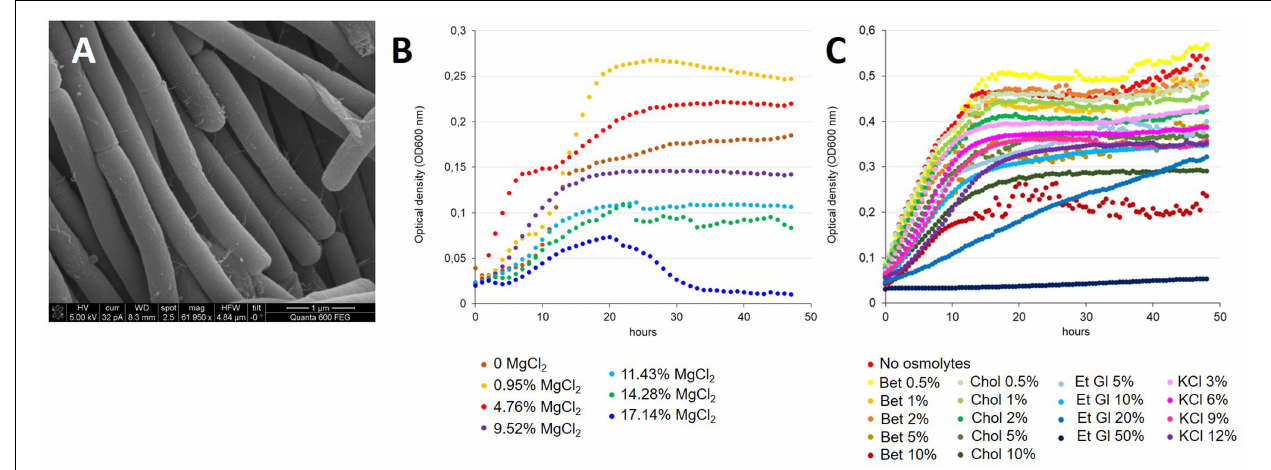
FIGURE 1 | Morphology (A) and growth (B,C) of V. dokdonensis strain 21D. In (A) , SEM image of strain 21D. In (B) , strain 21D growth in presence of increasing concentrations of MgCl 2 . In (C) , strain 21D growth in presence of increasing concentrations of different osmolytes. Bet, betaine; Chol, choline; Et Gl, ethylene glycol;